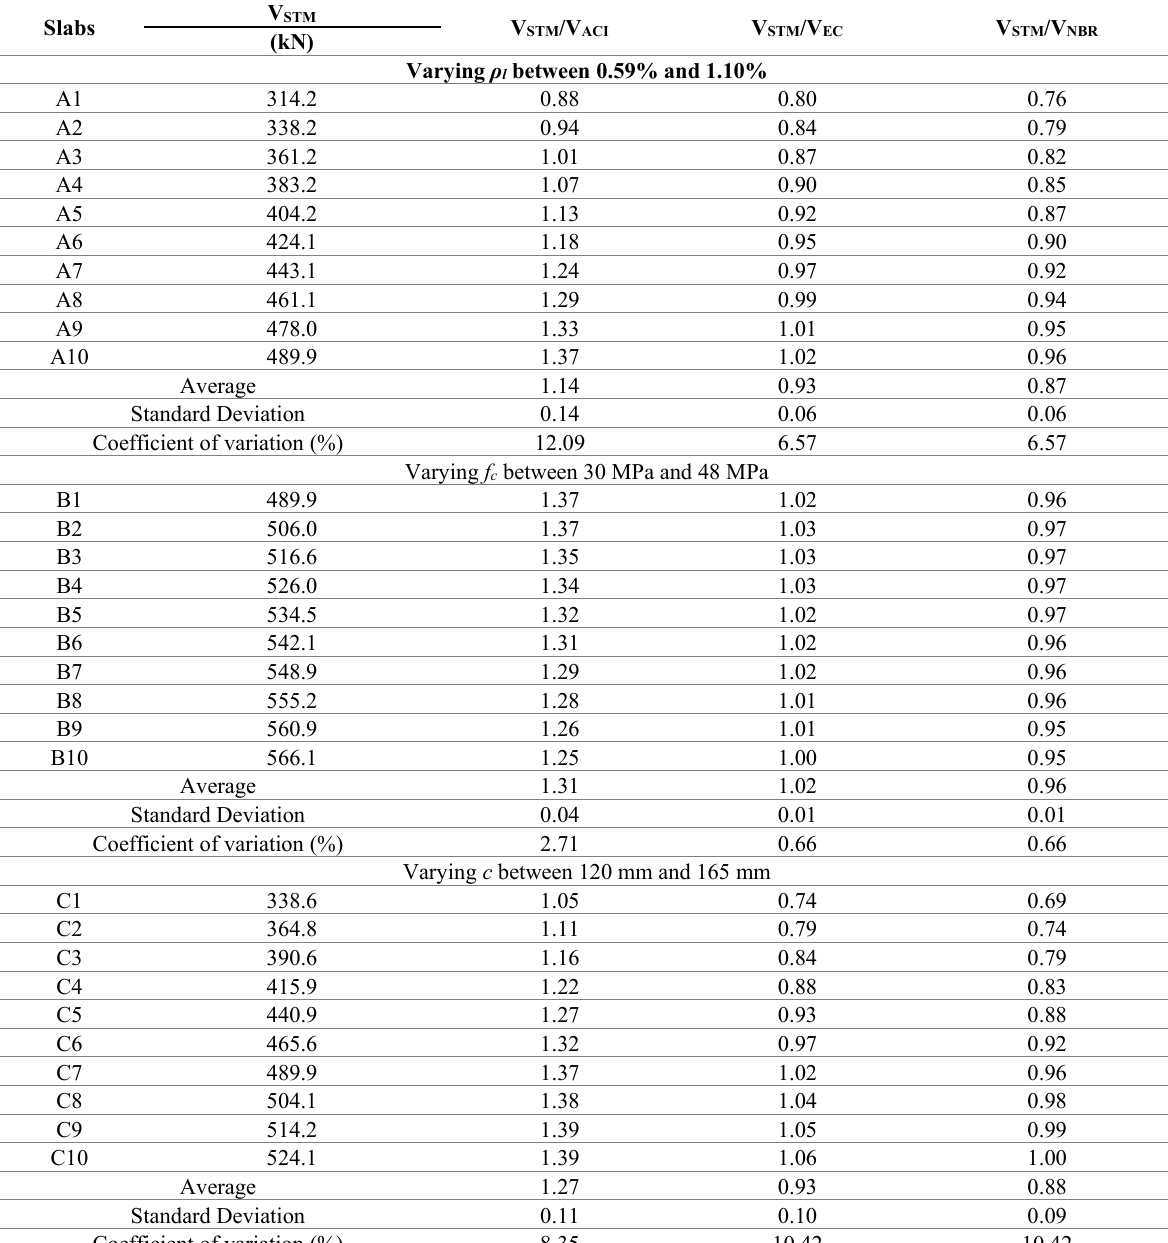
Table 2. Results of the analyzed